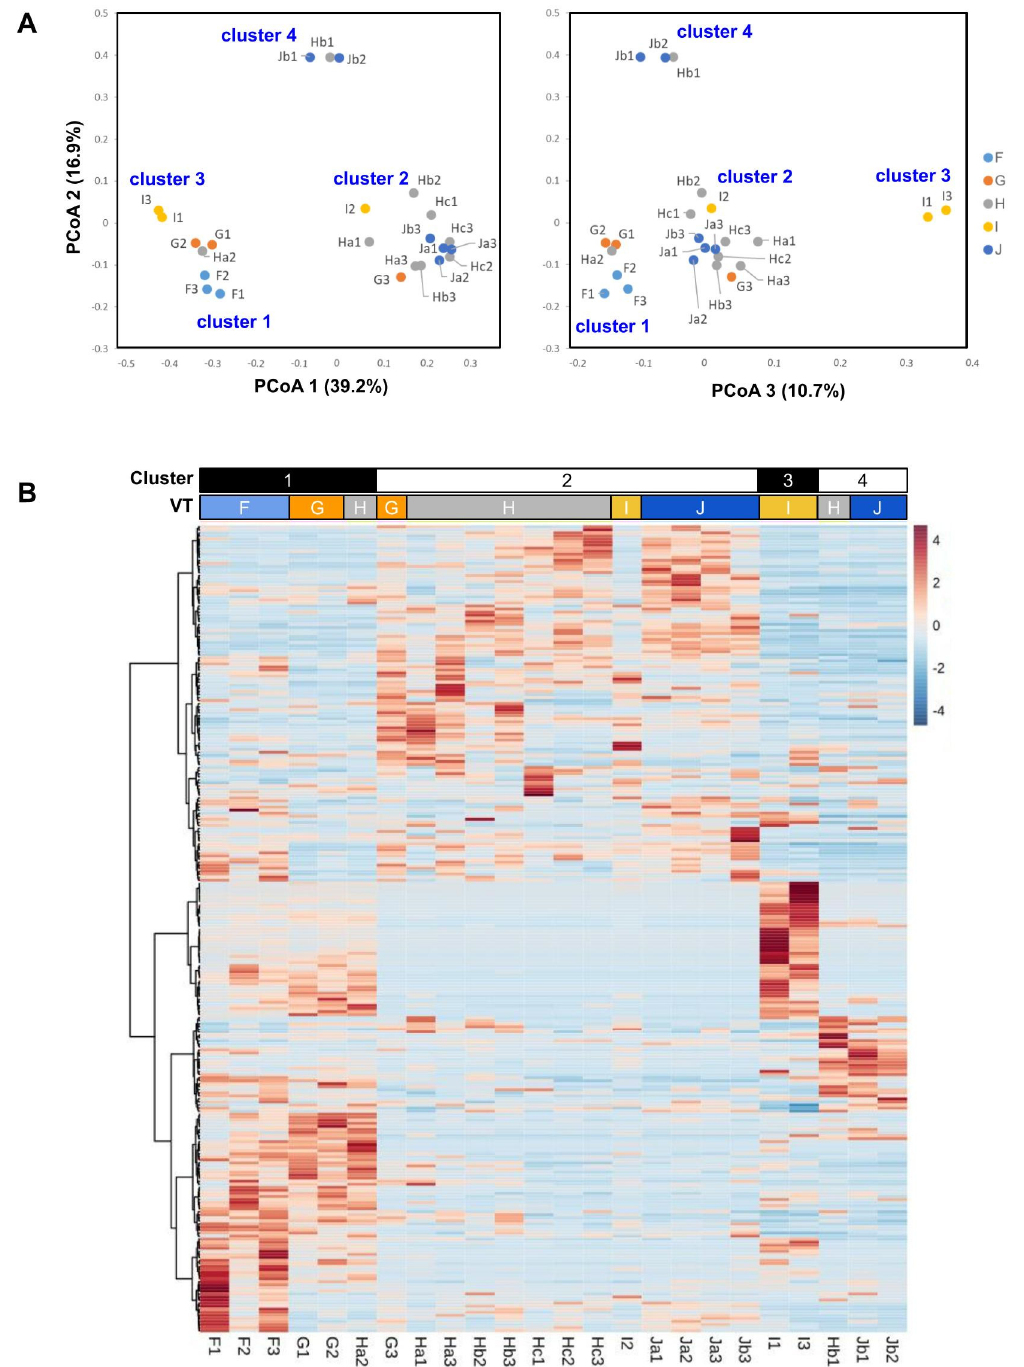
Figure 4. Bacterial community composition of YYL soil form four clusters. ( A ) PCoA analysis results revealed that these samples form four clusters. Distribution of samples on Axis 1/2 ( left ) and 2/3 (right). Samples are colored by the vegetation type they represent. PCoA clustering is in general consistent with the vegetation types. The Bray-Curtis dissimilarity was used to calculate inter-community distance. ( B ) Heatmap of bacterial genera depicting the differential distribution of each taxon among samples. Compositions presented here are grouped by PCoA clusters (Cluster) and labeled with the respective vegetation type and sampling plot. The Euclidian distance and Ward clustering algorithms were used for hierarchical clustering. VT, vegetation type.